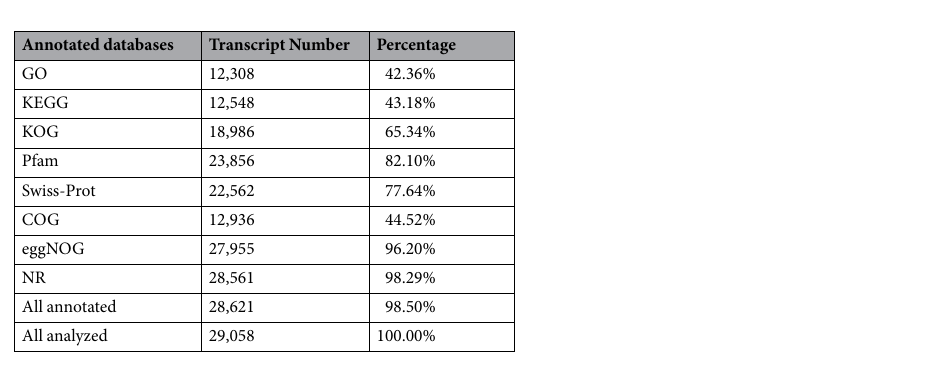
percentage of transcripts that were annotated in a single database ranged from 42.36% to 98.29% (Table 4). These results indicate that most of the genes in our datasets are likely functional genes in Z . japonica .